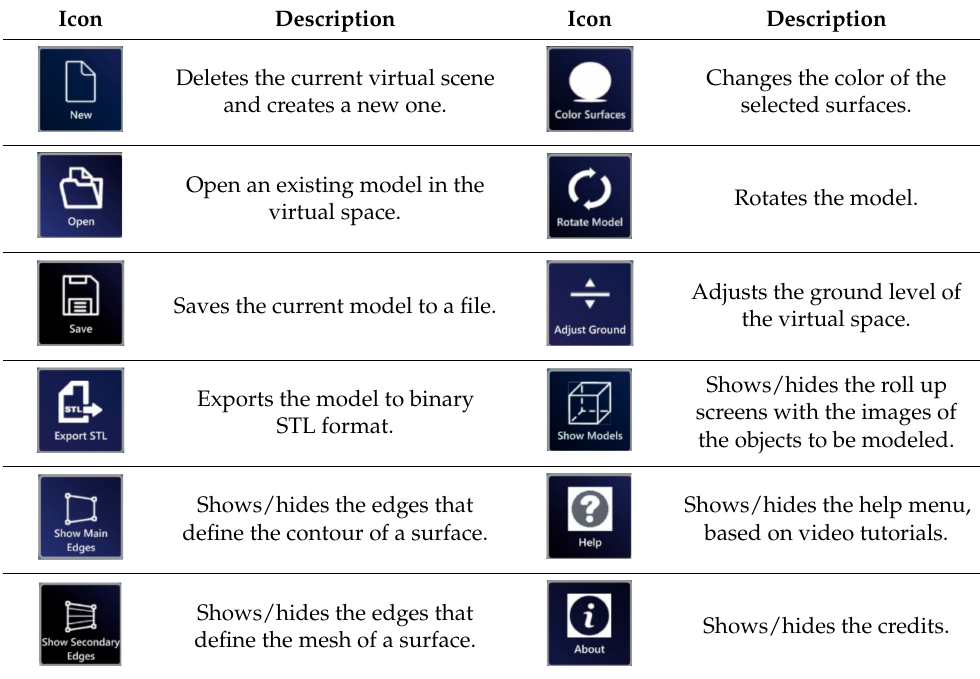
Table 5. Commands to manage files, visualization, and settings.